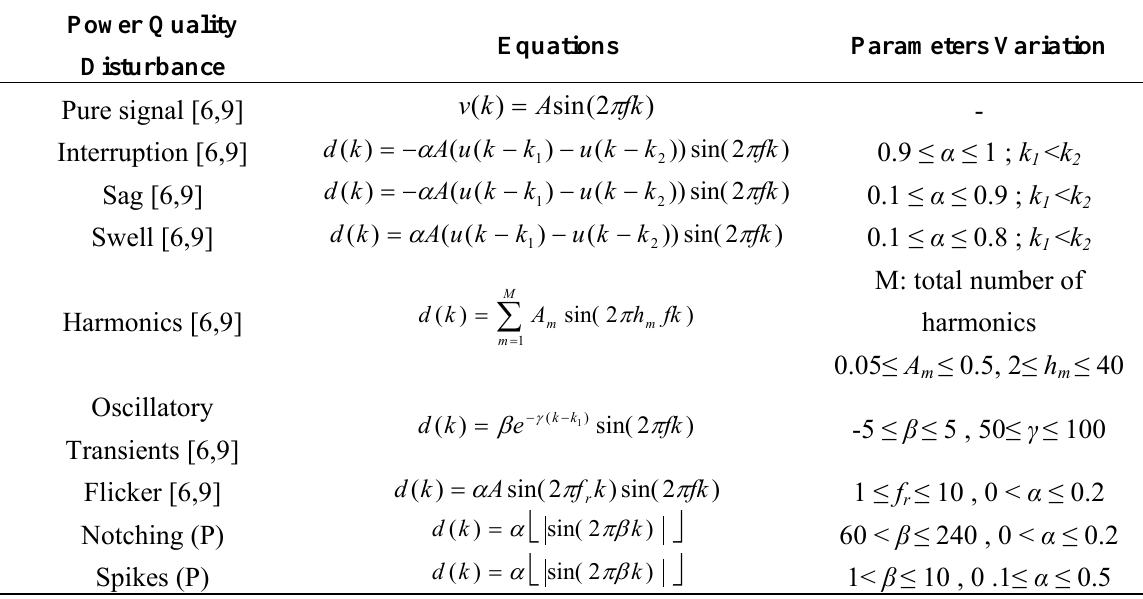
Table 3. Power quality disturbances